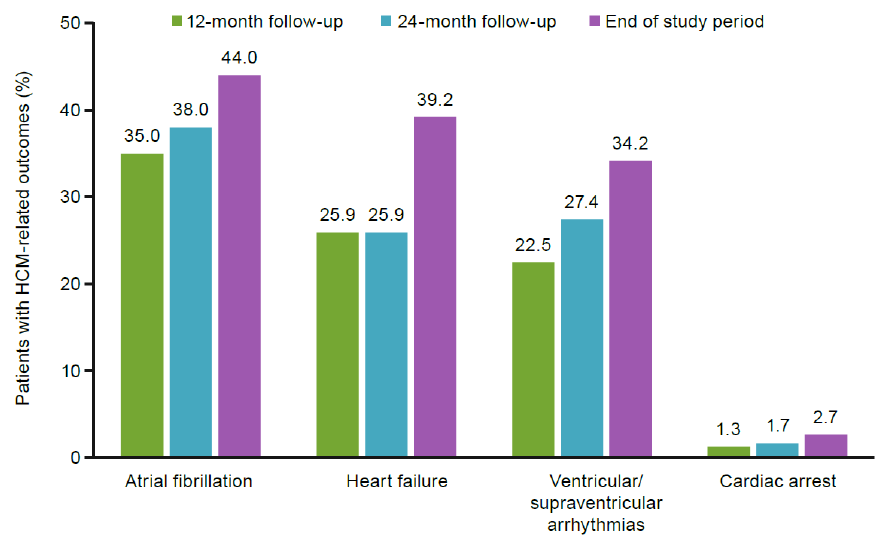
Figure 3. Patients with HCM-related outcomes. HCM: hypertrophic cardiomyopathy.